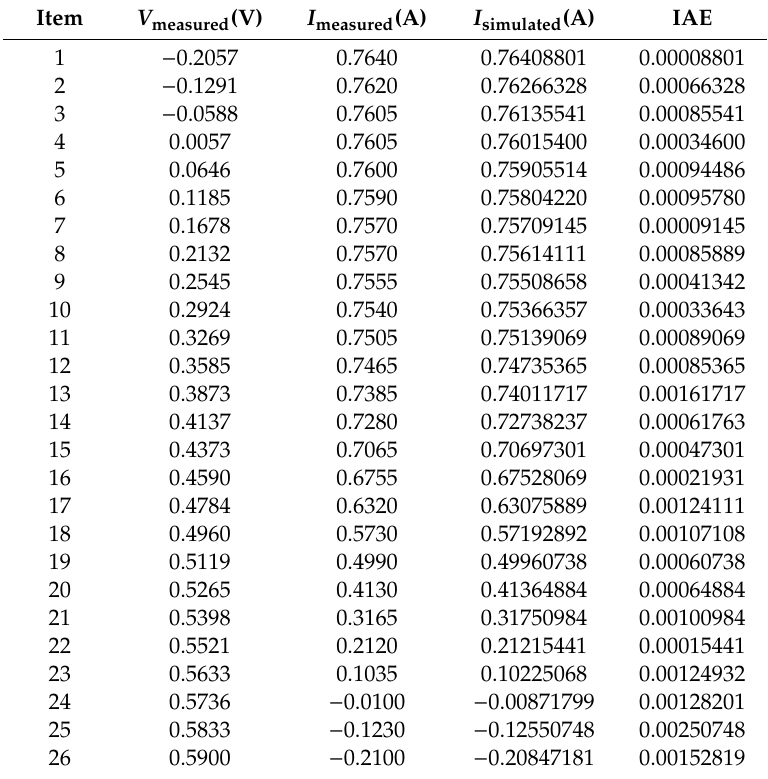
Table A2. Absolute error of IMFO for each measured on the single diode model.